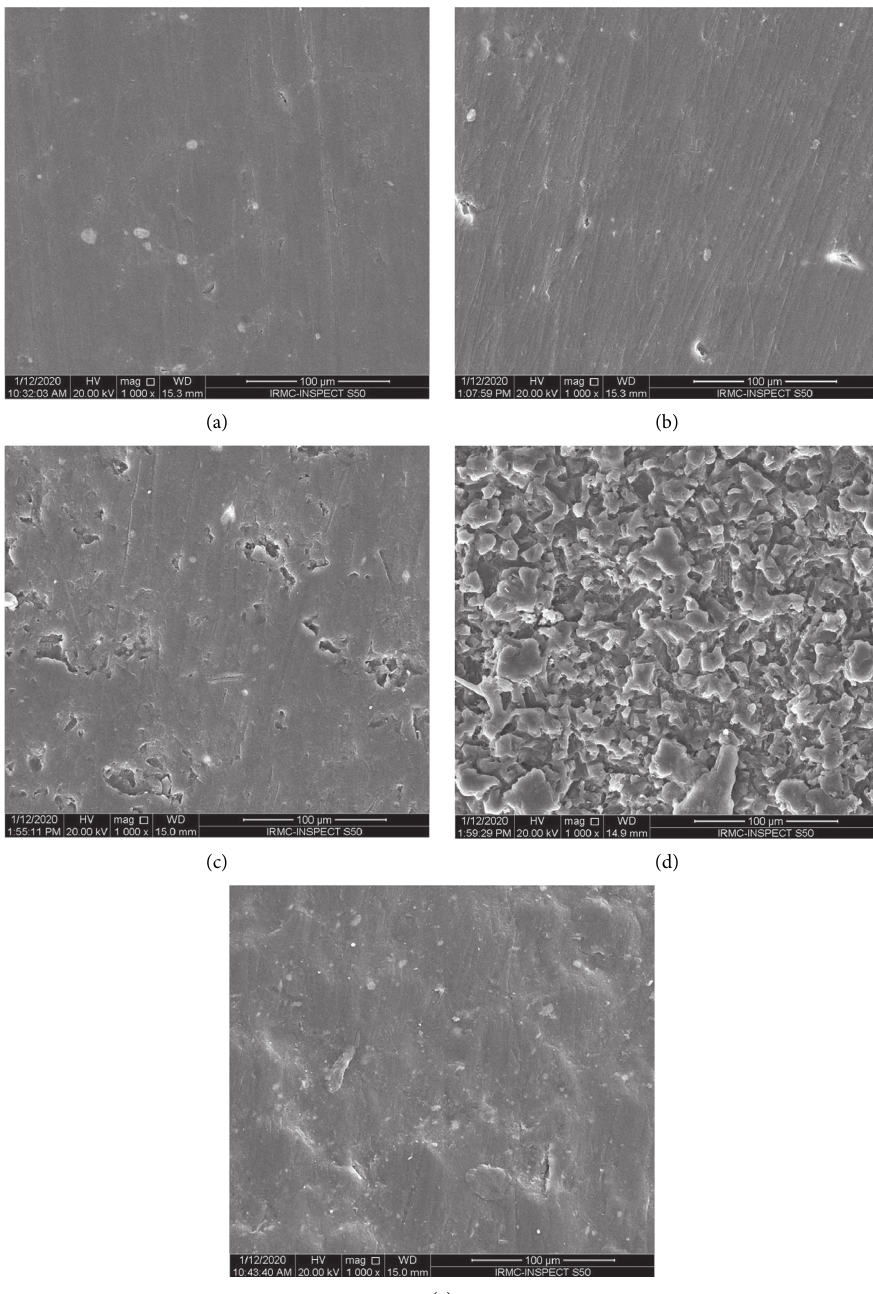
Figure 4: (a–e) Representative SEM for specimen surfaces unmodified specimens after immersion. (a) Baseline. (b) Distilled water. (c) Corega. (d) NaOCl. (e)